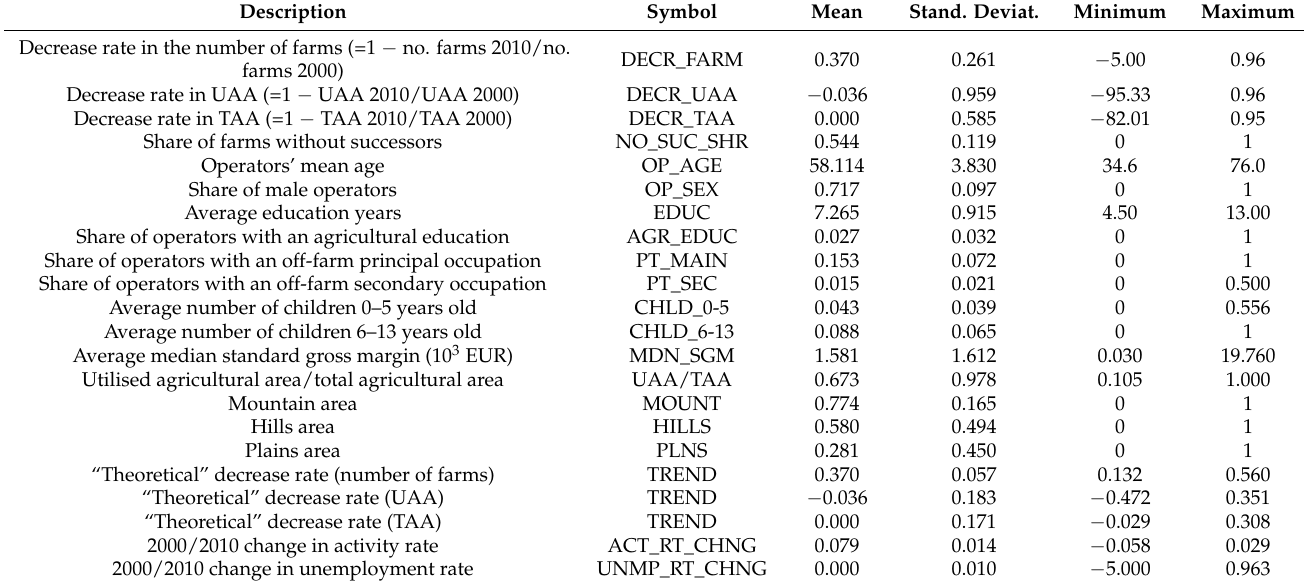
Table 2. Descriptive statistics of the